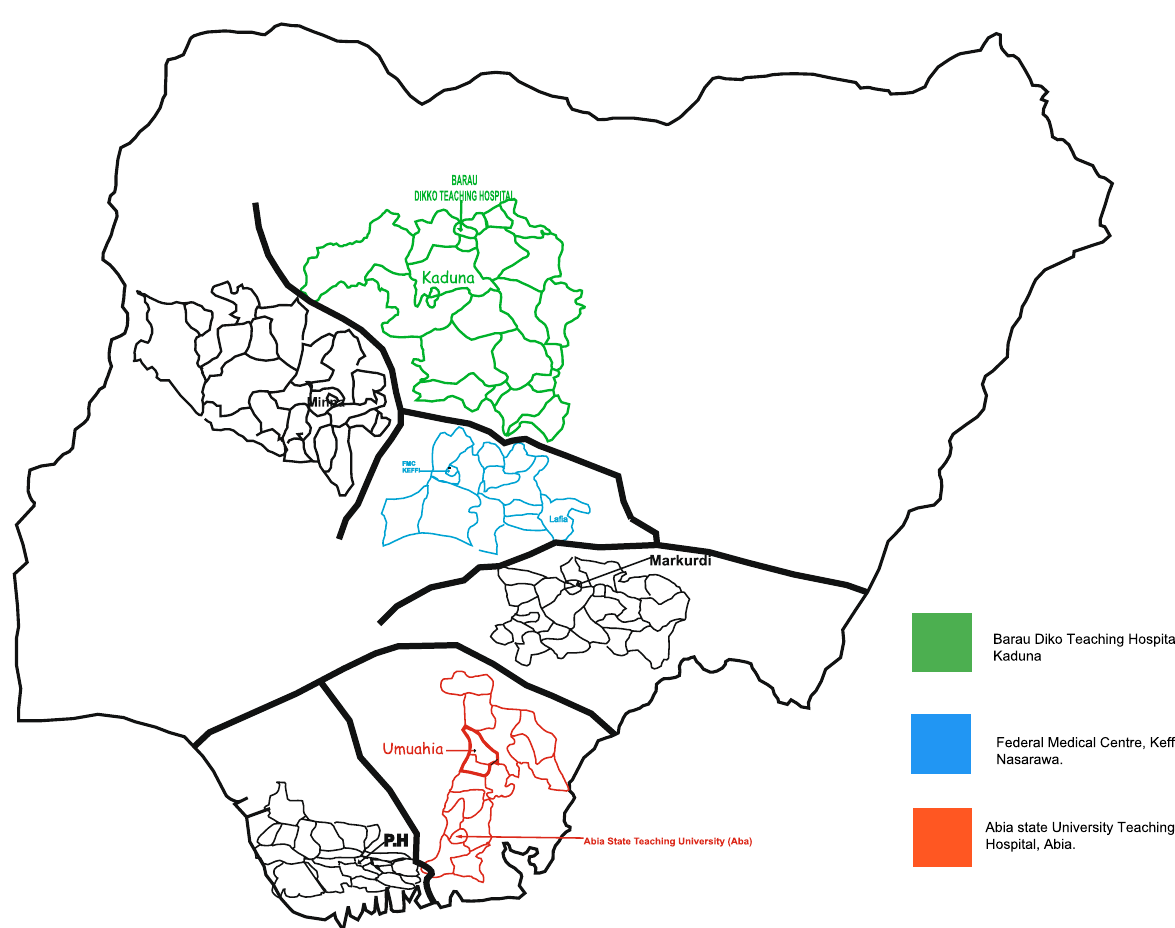
Fig. 1 Chikungunya and Zika arboviral study sites in